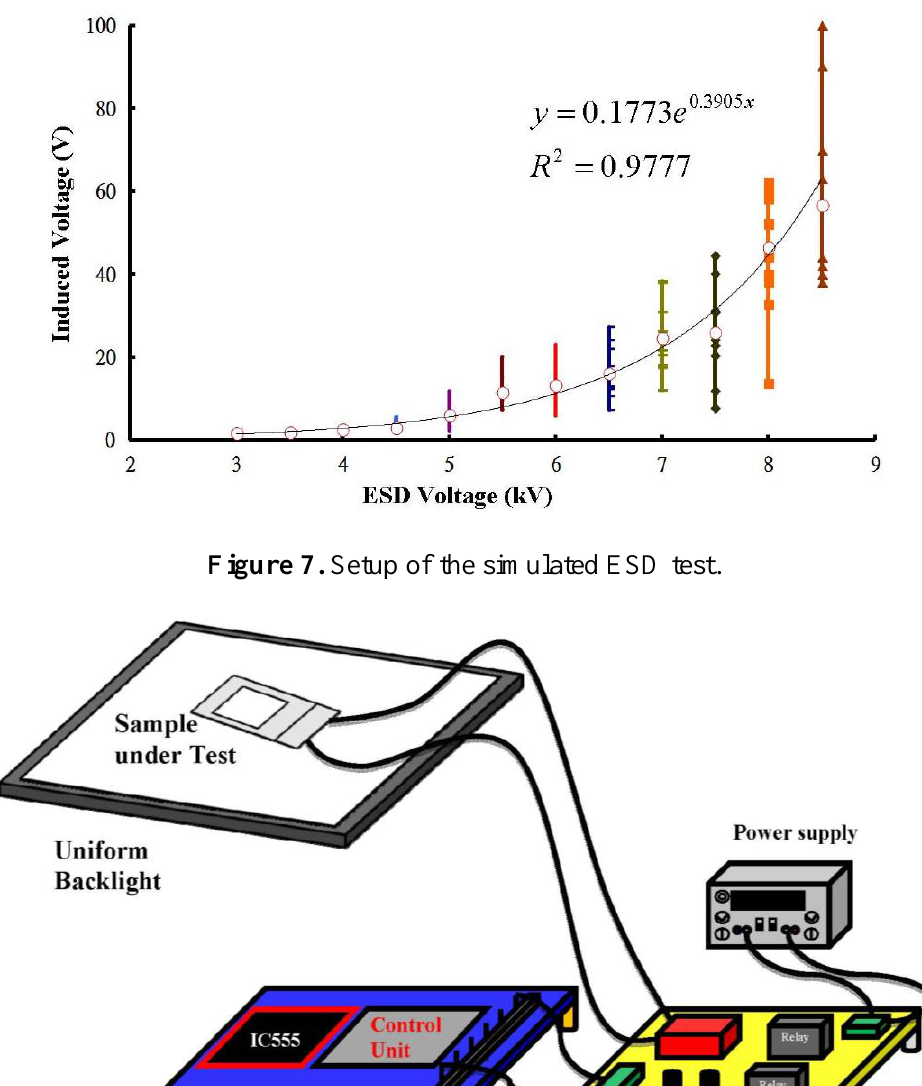
Figure 6. Induced voltages on the sample under test with an electrical gun operating in the air mode.